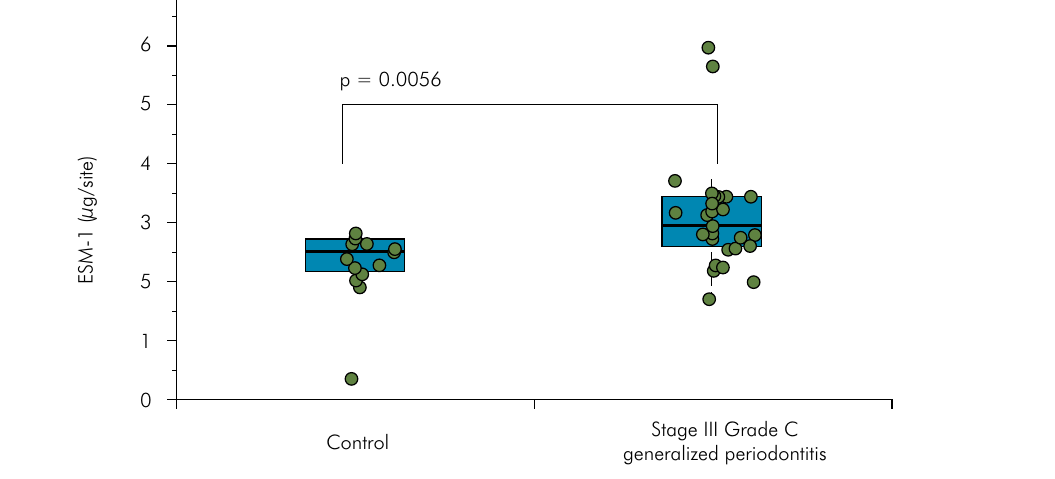
Figure 3. GCF levels of Endocan for periodontitis and control groups.